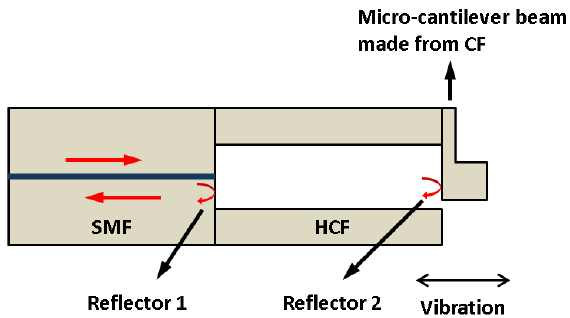
Figure 13. The configuration of on-fiber EFPI vibration sensor [97].